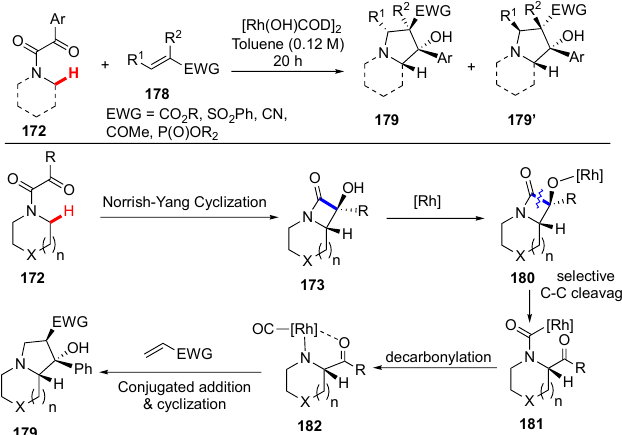
Scheme 22. Rh-catalyzed functionalization of cyclic